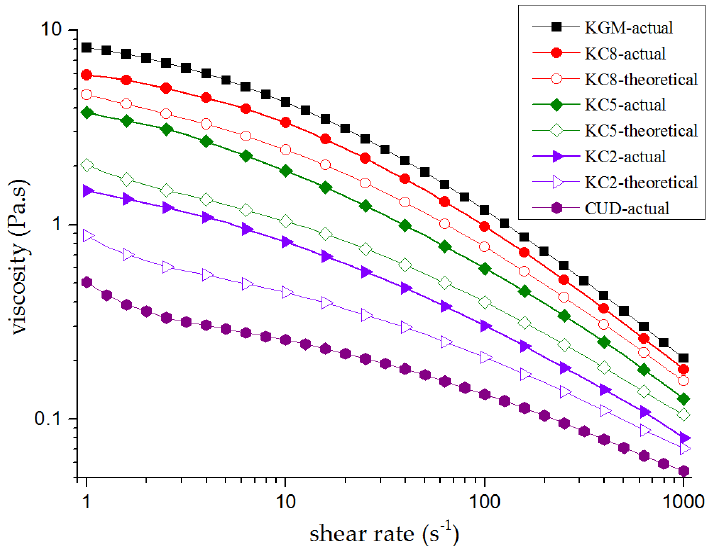
Figure 1. Relationships between the shear rate and both theoretical and actual viscosities of konjac glucomannan (KGM)/curdlan (CUD) blend systems under alkaline conditions (pH = 10.58).